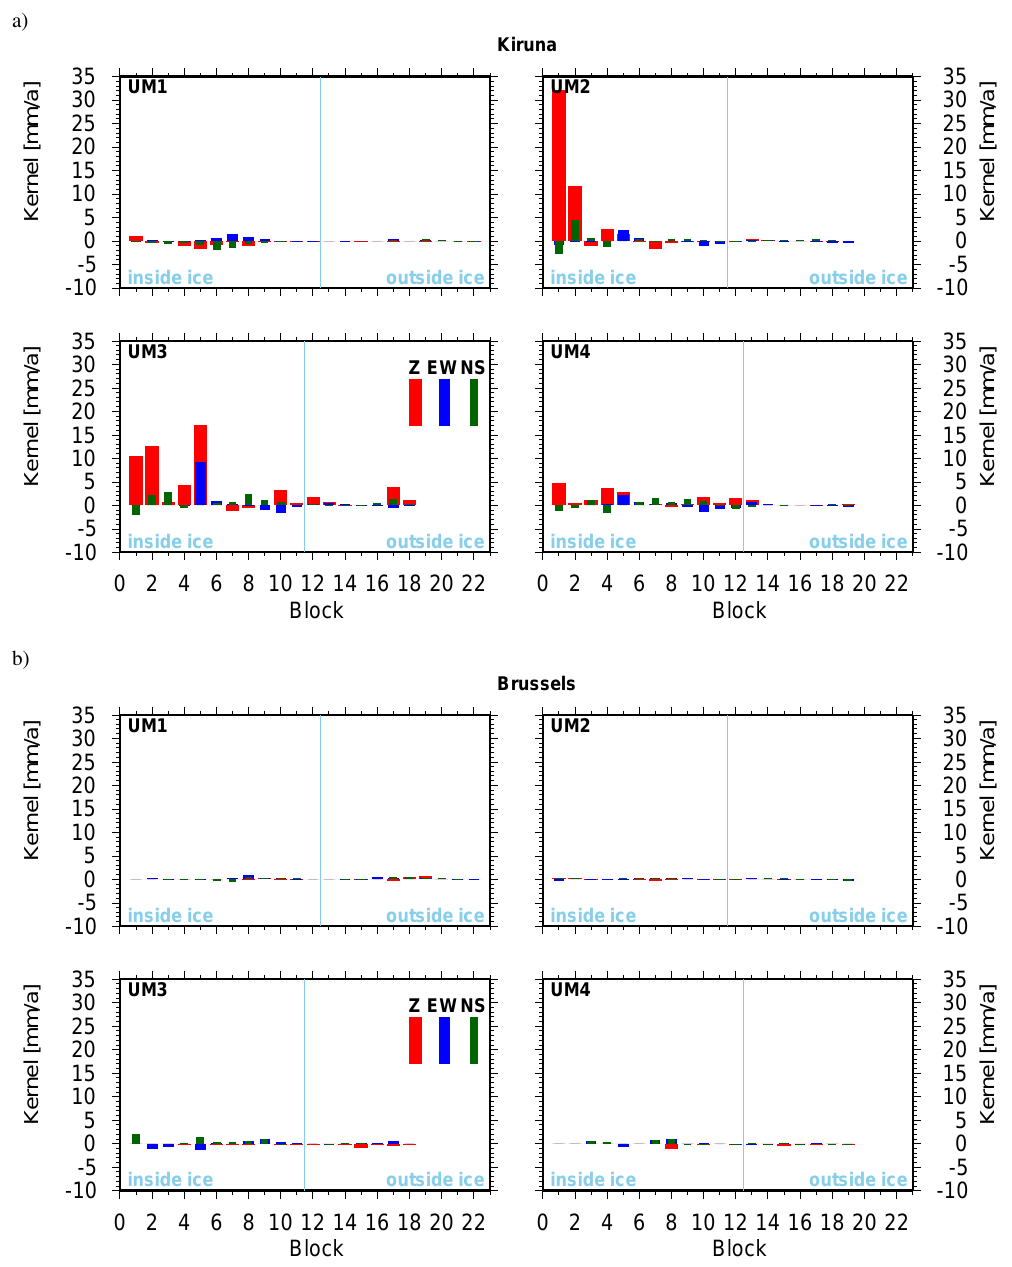
Fig. 3. Sensitivity kernels shown as bars for vertical (red) and horizontal velocities (EW: blue, NS: green) at the stations of (a) Kiruna, and (b) Brussels to viscosity blocks in the four layers of the upper mantle (UM1–UM4). Depth ranges: UM1 70 – 250 km, UM2 250 – 450 km, UM3 450 – 550 km, UM4 550 – 670 km.